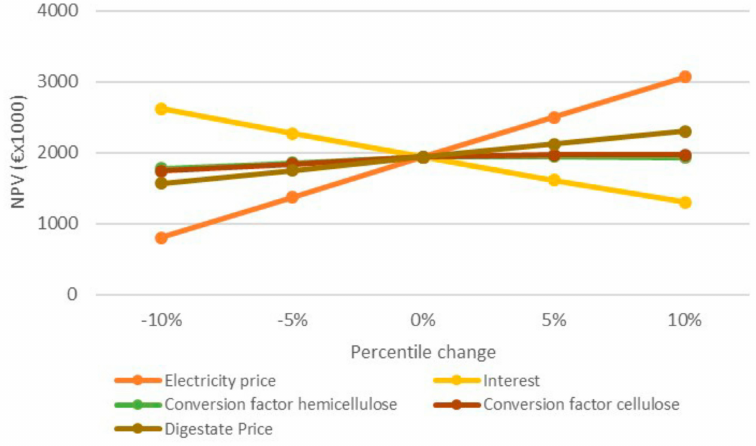
Figure 7. The influence of ± 5% and ± 10% change of the parameters on the profitability of biogas power plant that use GS as